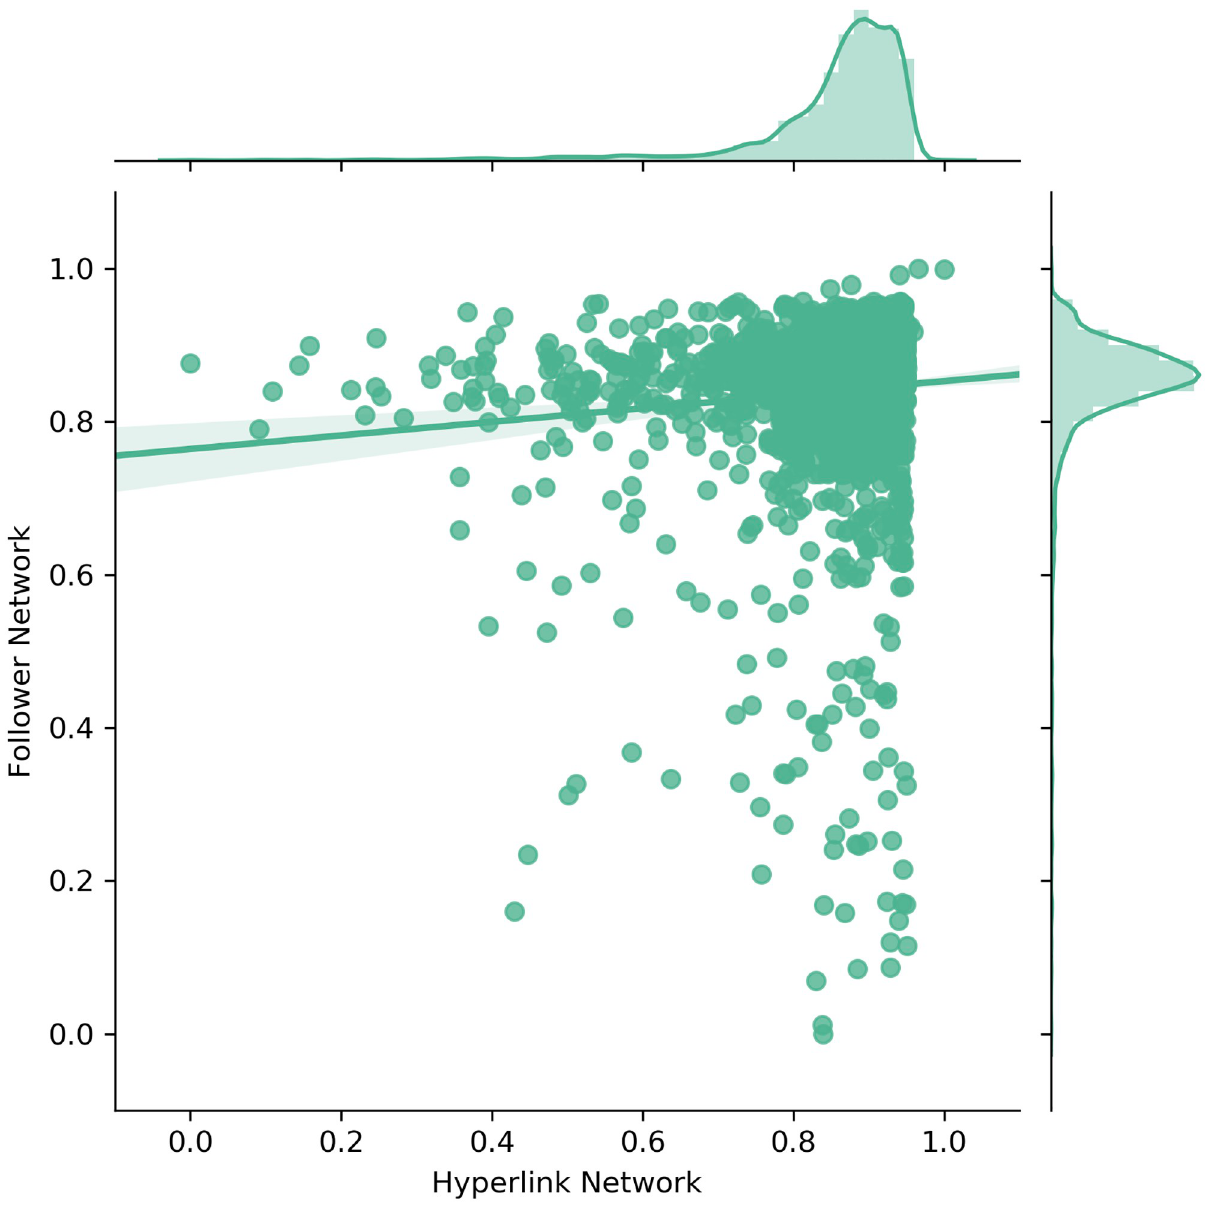
Fig 8. Scatter and density plots for geographic proximity non-zero